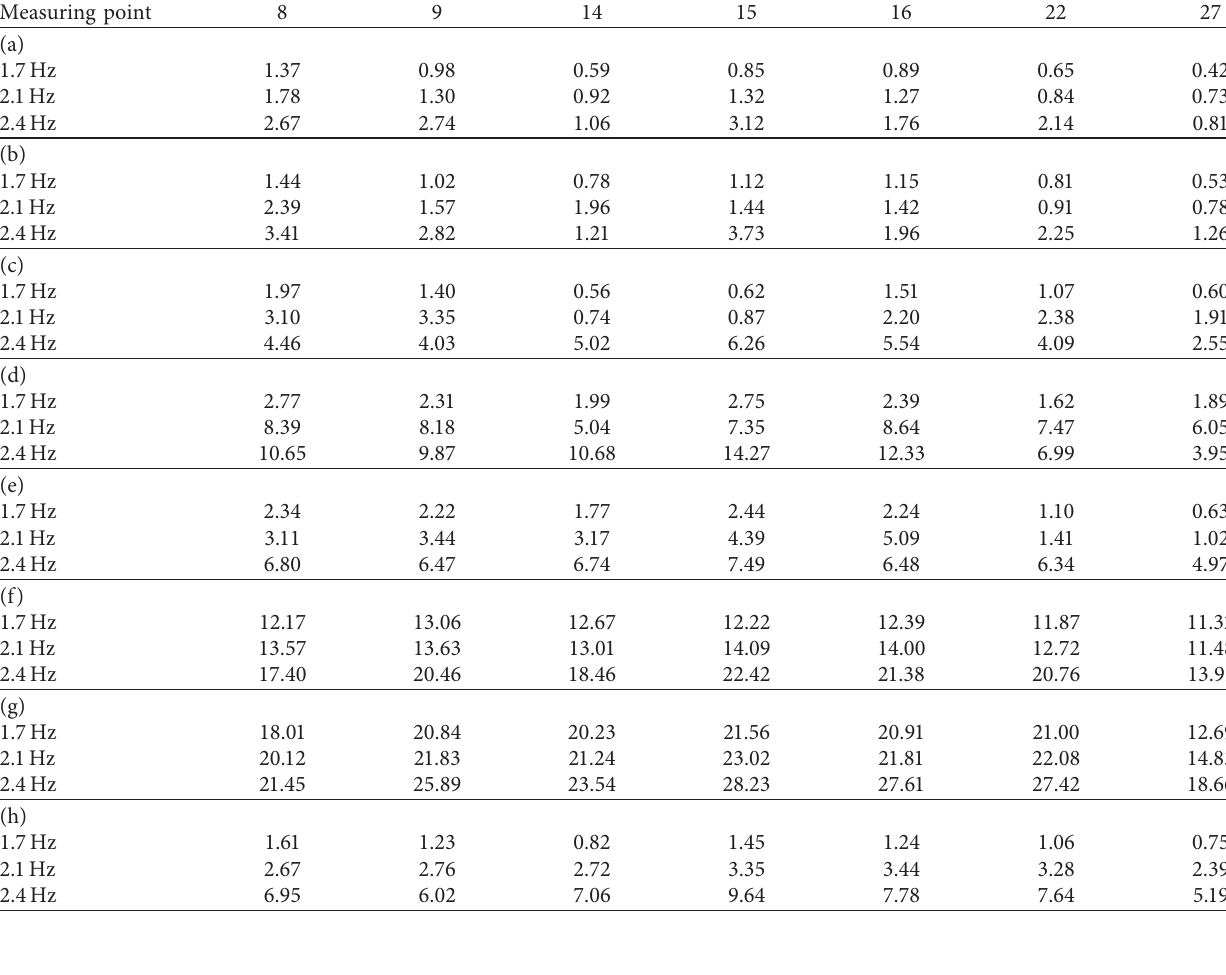
Table 4: The peak accelerations of the measured points under the eight test conditions. Measuring point